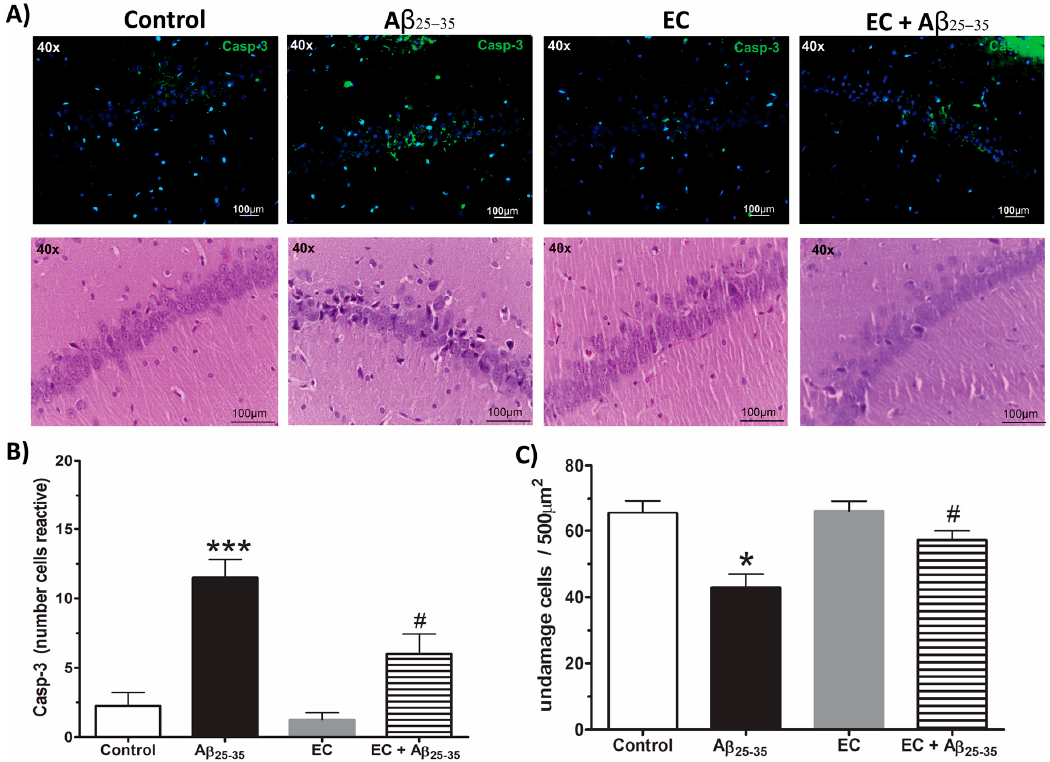
Figure 5. The epicatechin decreased the immunoreactivity of caspase-3 and the number of damaged cells in CA1 subfields of the Hp rats of injected with A β 25–35 . In ( A ) we observed the immunoreactivity for caspase-3 (green color) and the cells stained with H & E of the CA1 subfield of the Hp of rats control, A β 25–35 , EC, and EC + A β 25–35 groups. The epicatechin treatment decreases the number of immunoreactive cells to caspase-3 ( B ) and a number of damaged cells in the CA1 Hp of rats injected with A β 25–35 ( C ). The mean ± SE is plotted. Data were analyzed with one-way ANOVA and post-test Bonferroni test (* p < 0.05 and *** p < 0.001) comparing all groups with respect to the vehicle group. # p < 0.05 compared the A β 25–35 and EC + A β 25–35 groups.